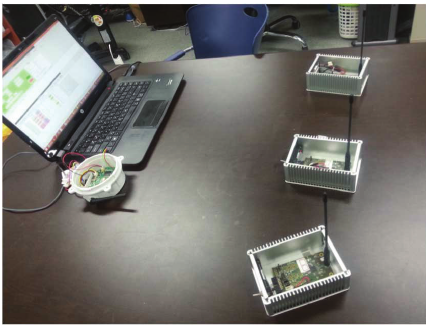
Figure 3: TRA-MAC test bed.